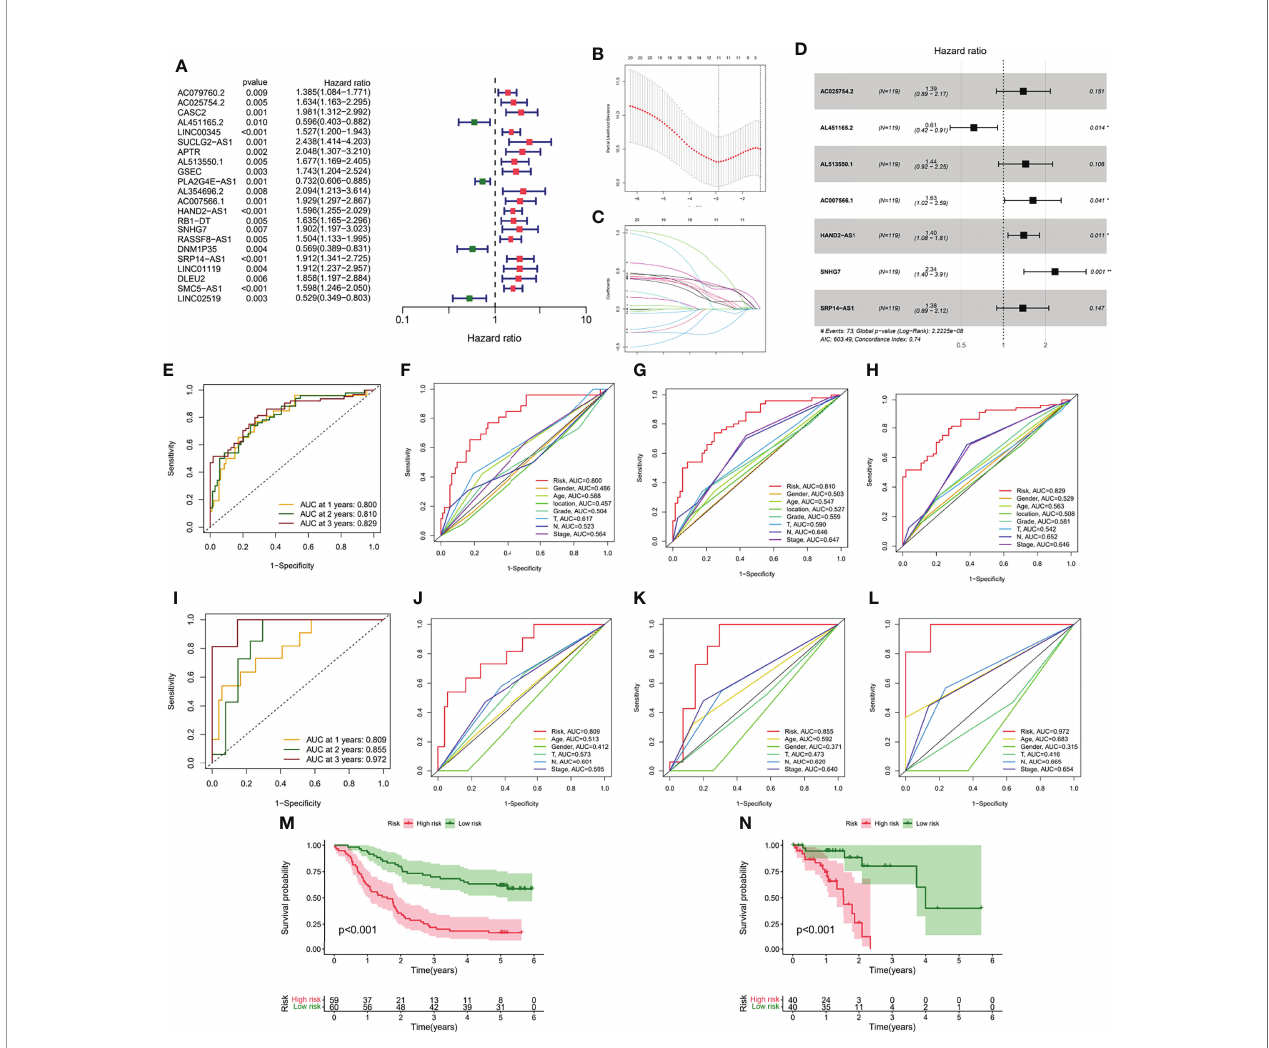
FIGURE 6 | Generation and veri fi cation of the m7G-LPS. (A) Univariate Cox regression analysis for 22 lncRNAs. (B) Cross-validation for tuning the coef fi cient selection in the LASSO regression. (C) LASSO regression of the 22 OS-associated lncRNA. (D) Multivariate Cox regression analysis for 7 lncRNAs. ROC curves and their AUC value represented 1-, 2-, and 3-year predictions in the GEO cohort (E) and TCGA cohort (I) . The 1-year (F) , 2-year (G) and 3-year (H) ROC analysis revealed the AUCs of m7G-related lncRNA risk score and other clinical characteristics in the GEO cohort. The 1-year (J) , 2-year (K) and 3-year (L) ROC analysis revealed the AUCs of m7G- related lncRNA risk score and other clinical characteristics in the TCGA cohort. Kaplan-Meier curve of overall survival of the GEO (M) and TCGA cohorts (N)